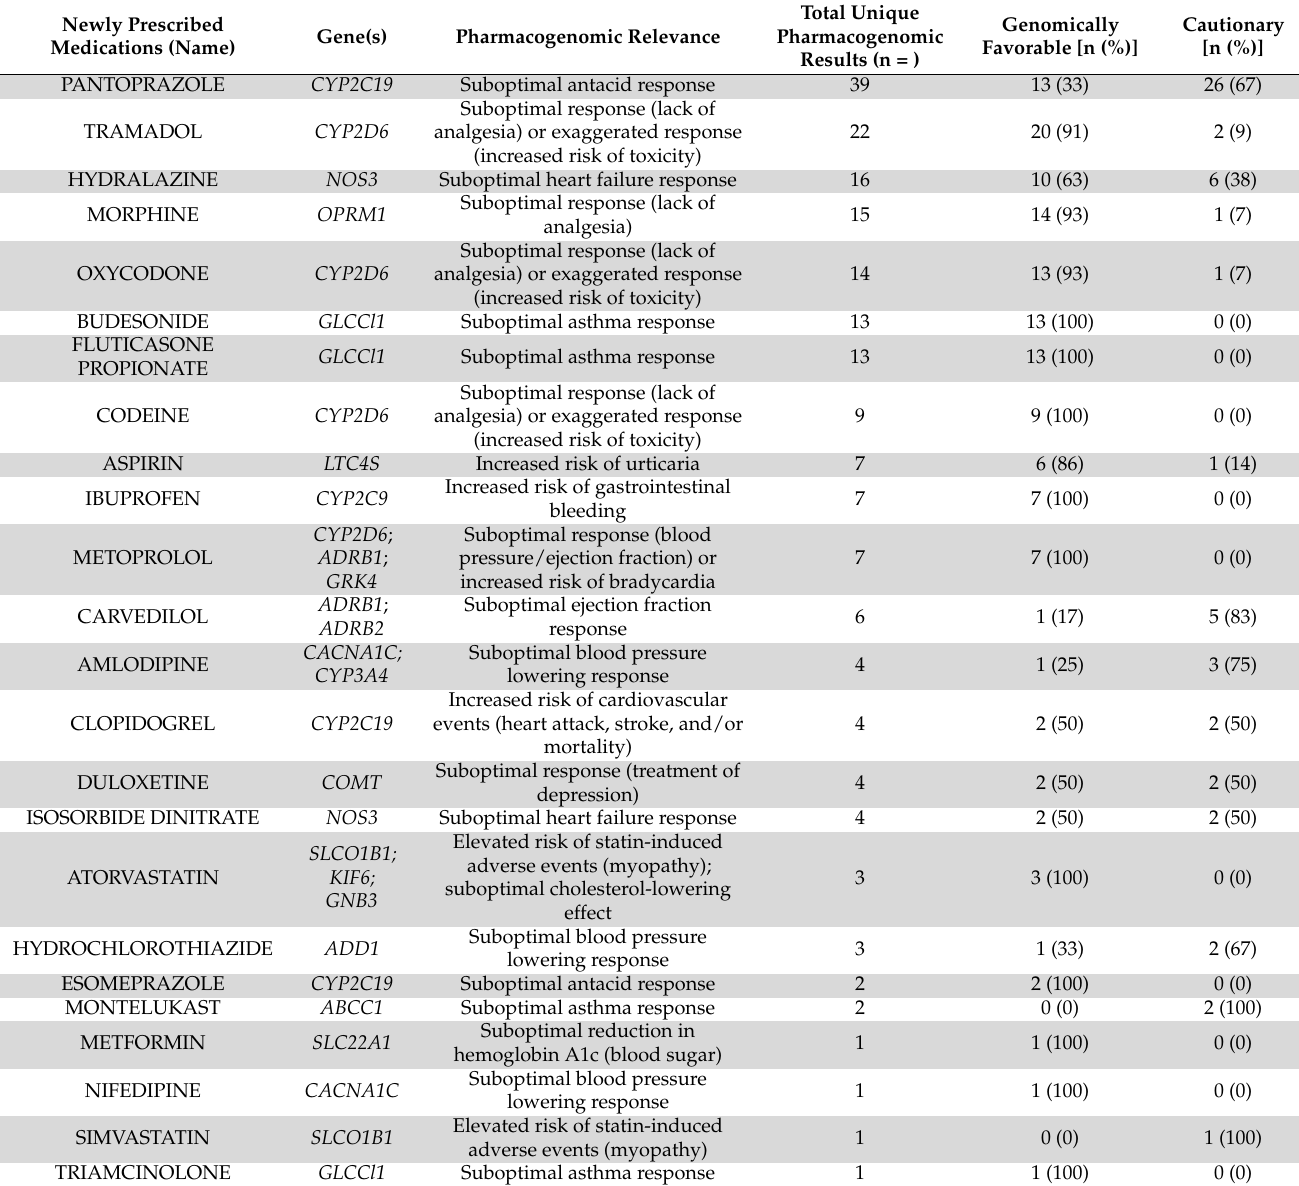
Table 3. Pharmacogenomic results available for newly prescribed medications during hospitalizations. All pharmacoge- nomic results that were available via the GPS at the point-of-care for newly prescribed medications during the study are shown. Results were categorized as genomically favorable (green light) vs cautionary genomic risk (yellow light) based on each individual patient’s genetic test results. Providers accessing individual results received detailed clinical decision support summaries to guide/inform